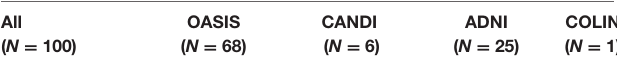
TABLE 2 | Proposed method overall dice results for the full dataset and for each of the subsets.